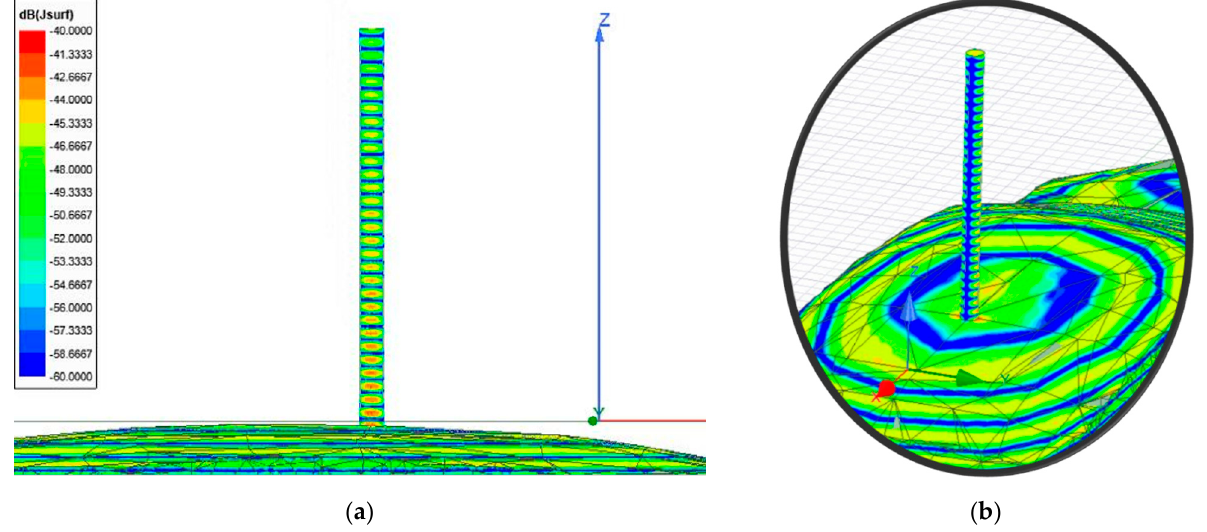
Figure 4. Surface current imagery distribution generated by Ansys HFSS software in the monopole installed on a 10 cm long vehicle illuminated at 300 GHz: ( a ) lateral view of the monopole antenna showing the surface current distribution; ( b ) magnification of the monopole antenna to show the current distribution across the surface.